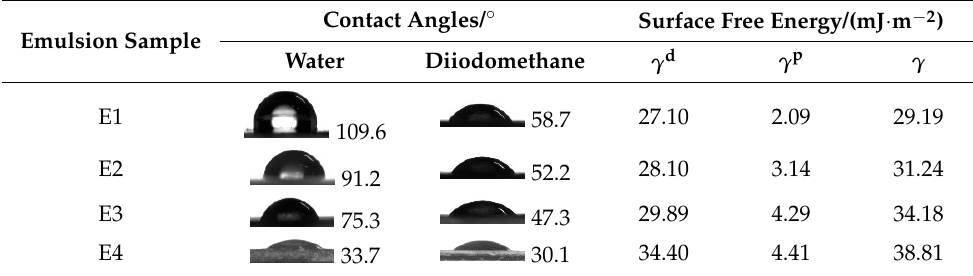
Table 3. Surface free energy of the sizing-treated paper fabric with different emulsions. Emulsion Sample